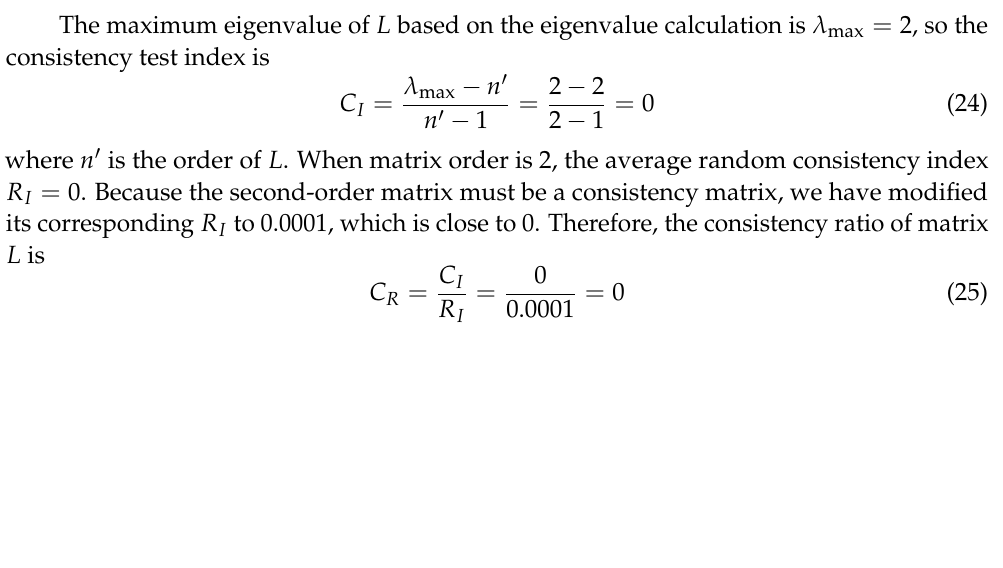
Figure 20. Comparison of expected utility and online utility.